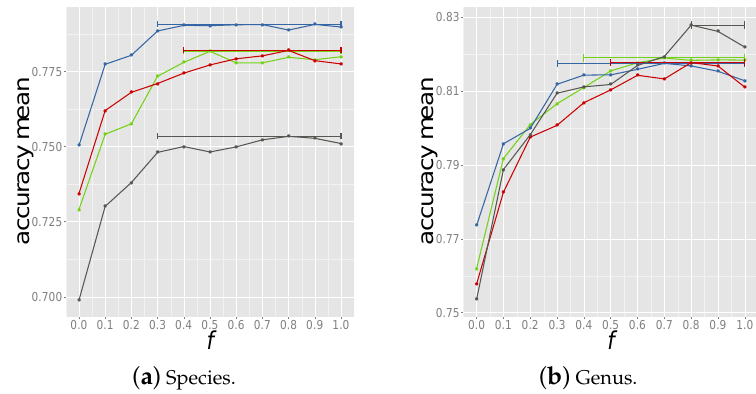
Figure 2. Accuracy vs. f values obtained from the 4 loops of inner cross validation. Each dot represents the averaged accuracy for species (a) and genus (b) prediction over 100 bootstrap resamplings. The bars cover the range of f values for which the accuracy is 99% the highest accuracy in the specific tripartite set.